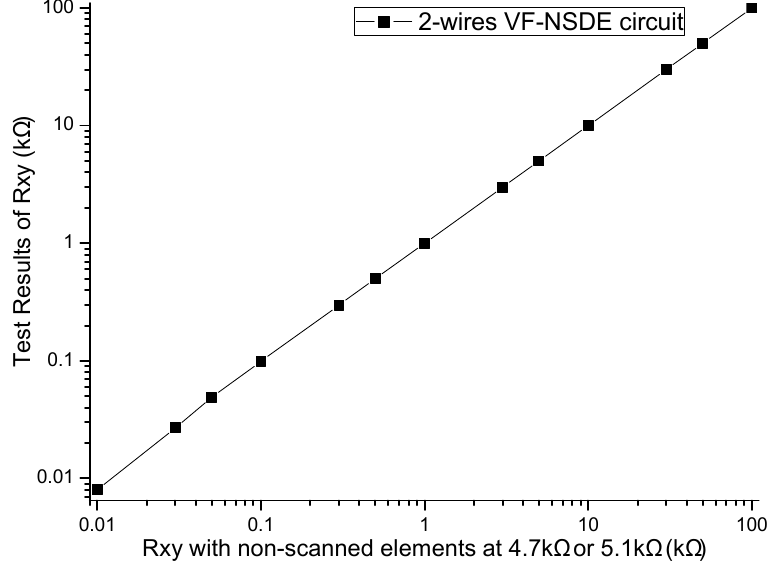
Ω to 100 k Ω in the prototype